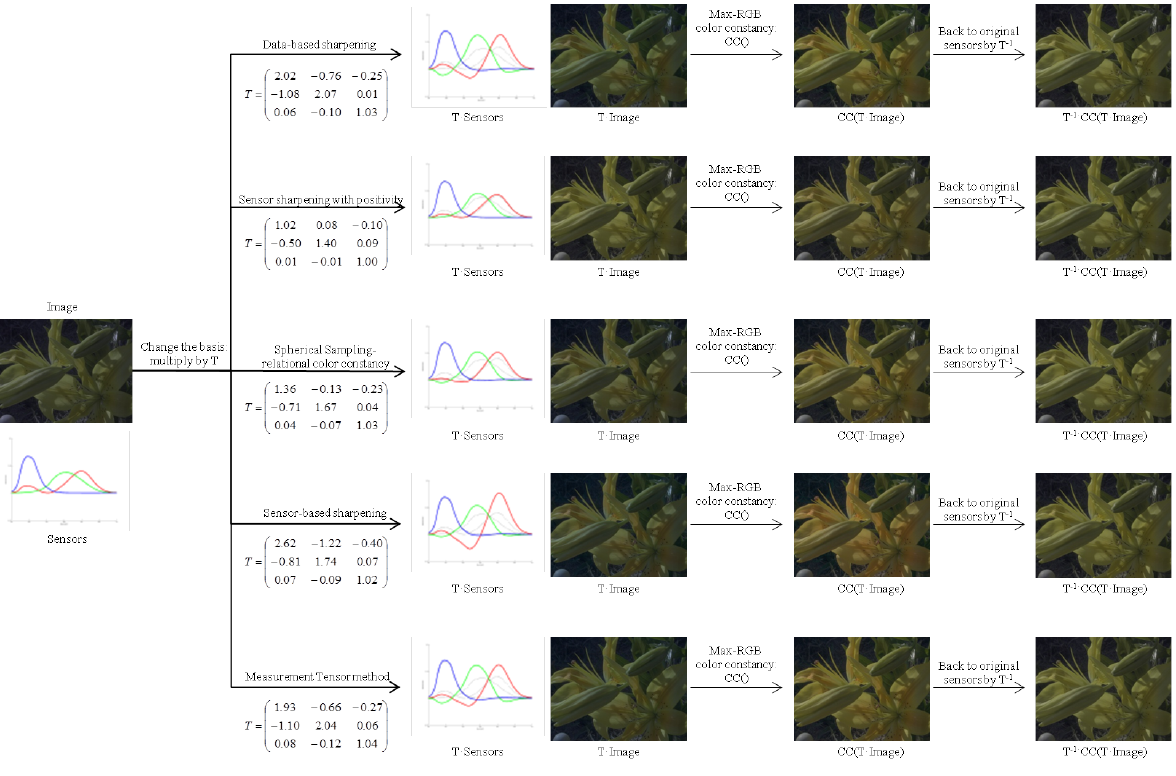
Figure 3. Example of diagonal color constancy using spectral sharpening for five different methods. The original image (sensors) is converted by a linear matrix T to a sharpened basis. Then, a diagonal color constancy method is applied (MaxRGB in this case). Finally, the resultant image is converted back to the original basis by the inverse of the matrix T . In this example, the original sensors are the CMF XYZ functions. The sharpening matrices have been obtained using the Planckian illuminants and the whole set of reflectances from [17]. The multispectral image comes from